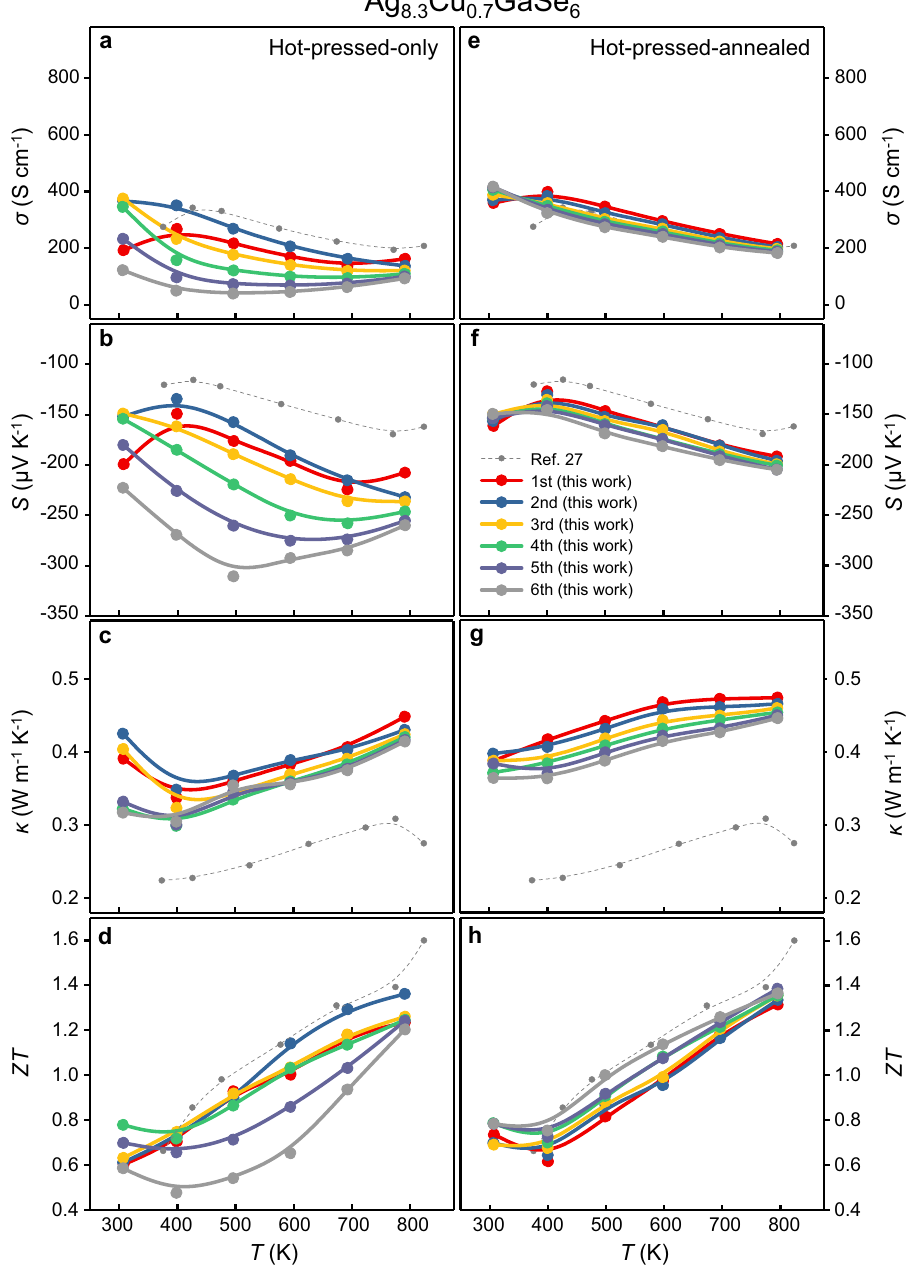
Fig. 4 Temperature-dependent thermoelectric properties of Ag 8.3 Cu 0.7 GaSe 6 . a – d hot-pressed-only and e – h hot-pressed-annealed samples. a , e Electrical conductivity σ . b , f Seebeck coef fi cient S . c , g Thermal conductivity κ . d , h Figure of merit ZT . The Dulong-Petit- C p was used. Those reported in ref. 27 that are calculated by the Dulong-Petit- C p are presented as references. The κ and ZT calculated by the measured- C p are provided in Supplementary Fig.